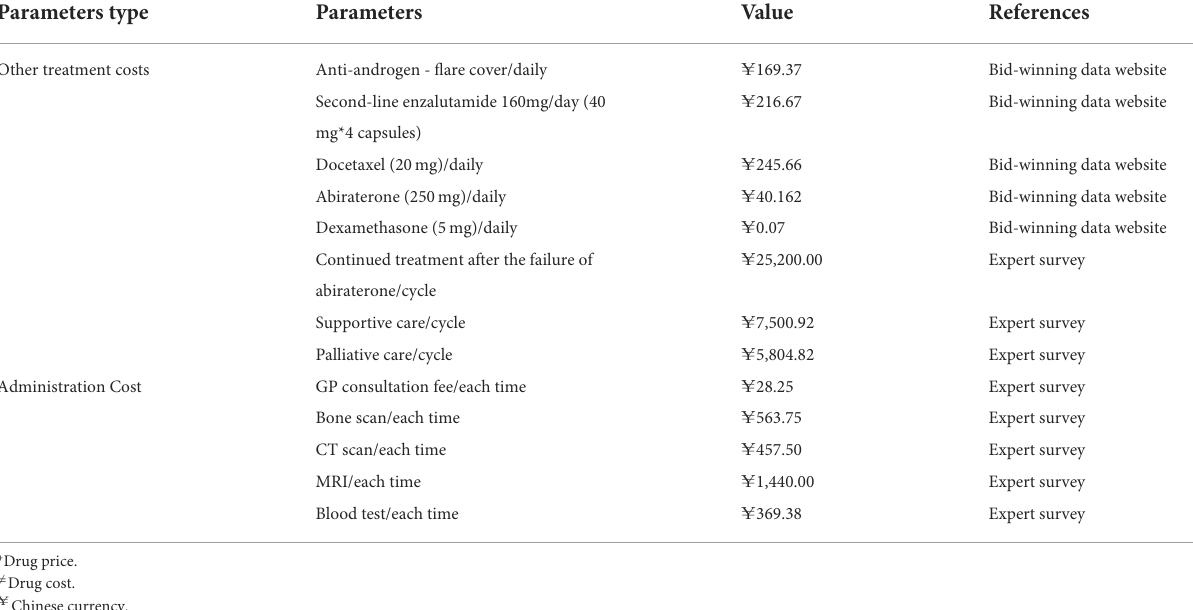
TABLE 5 Other treatment cost and administration cost.